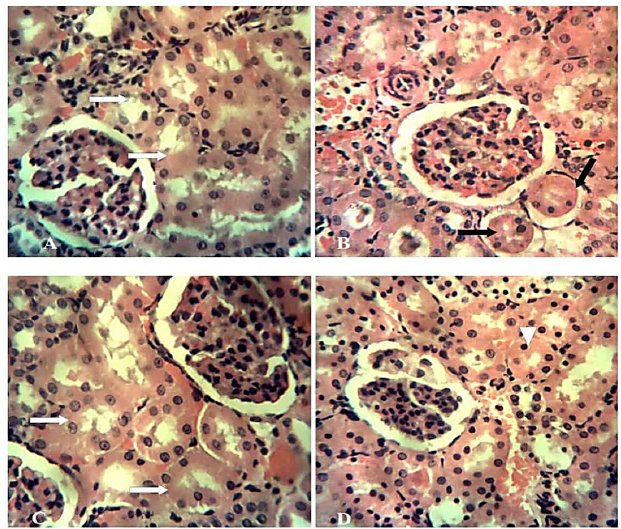
Figure 2. Photomicrograph of the kidney from groups A (control) and C (500mg/kg HMETV) rats showing the renal tubules (white arrows) with no observable histological change while groups B (CdCl 2 at 3 mg/kg) shows mild renal tubular degeneration (black arrows) Note the focal area of tubular epithelial cell apoptosis (arrowhead) in group D (CdCl 2 - 3mg/kg + 500mg/kg HMETV). HE